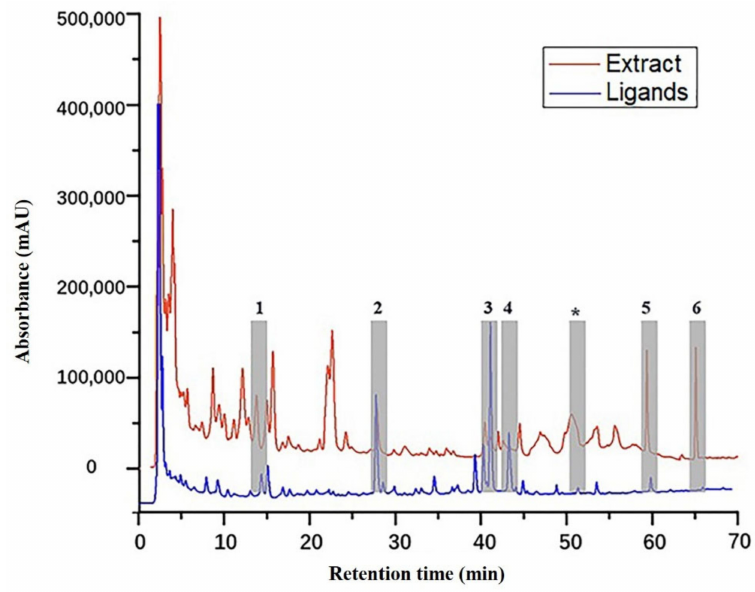
Figure 5. HPLC chromatograms of the ligands and